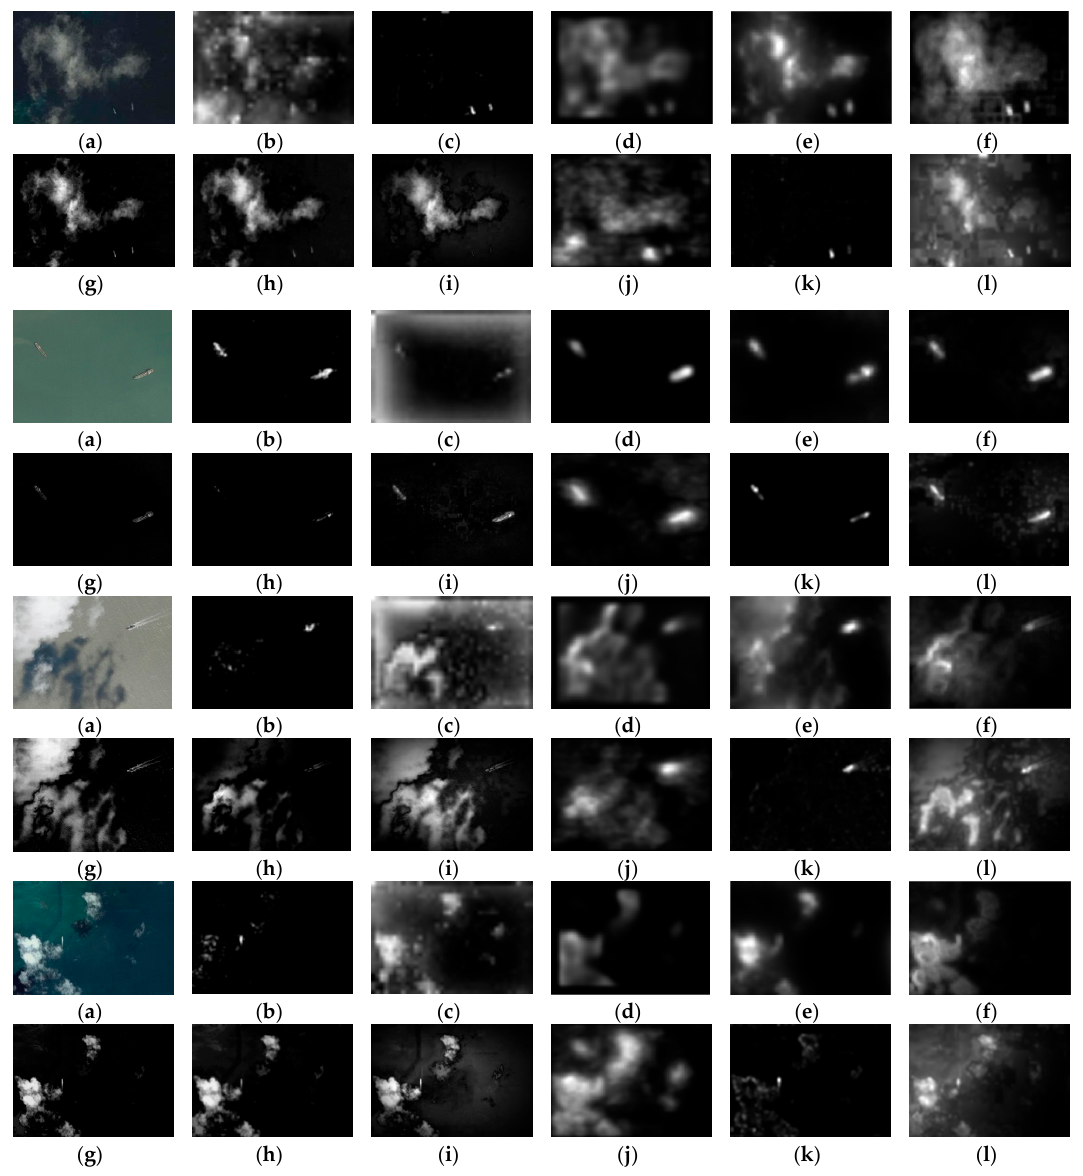
Figure 11. Visual comparison of the saliency maps: ( a ) input image; ( b ) WGS; ( c ) ITTI; ( d ) AIM; ( e ) GBVS; ( f ) CA; ( g ) LC; ( h ) MSSS; ( i ) SDSP; ( j ) RARE; ( k ) SR; and ( l ) Nevrez.